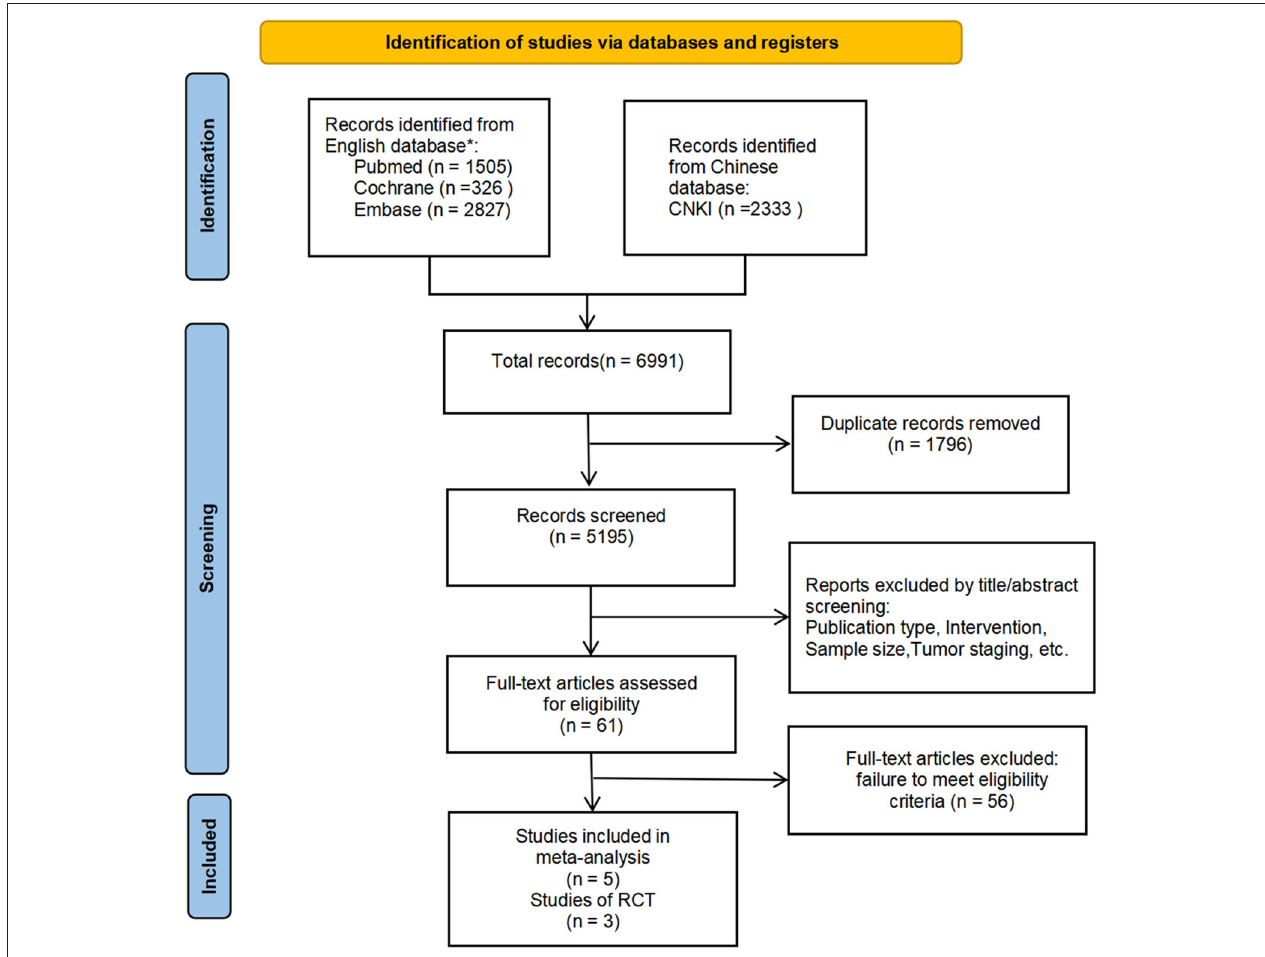
FIGURE 1 | PRISMA Flow Diagram. We also checked the corresponding citations from the references to make up for deficiencies in the search. According to whether non-RCTs are included or not, two analyses are carried out separately to interpret the data more comprehensively. *Relevant search terms are provided in Supplementary Materials